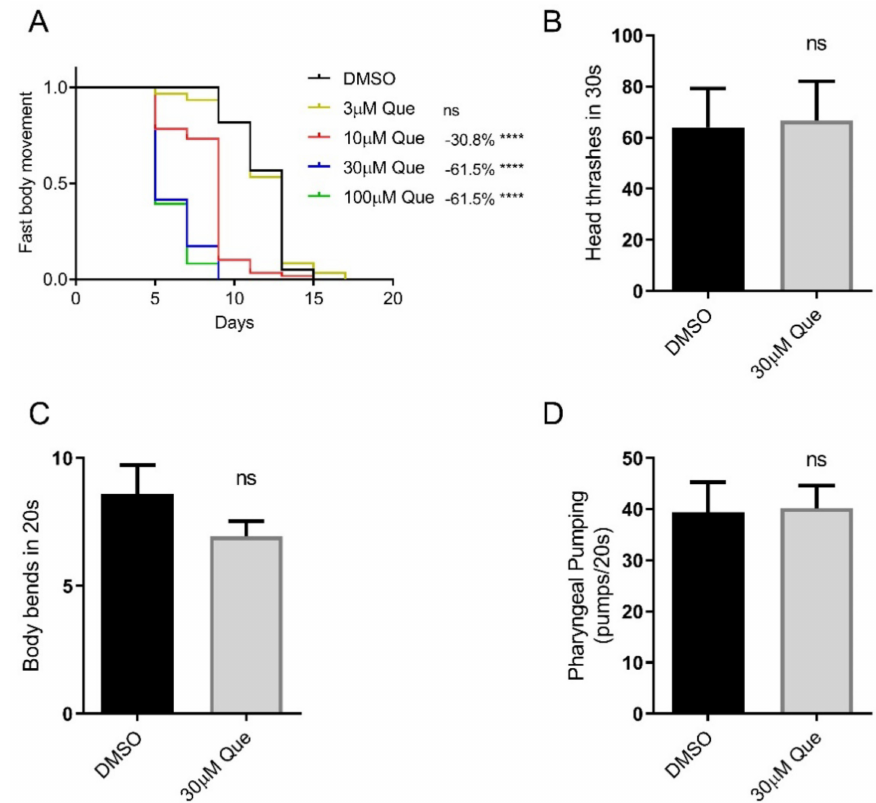
Figure 1. Quetiapine reduces healthspan but does not affect locomotion and pharyngeal pumping of C. elegans . ( A ) Fast body movement spans of wild-type (N2) worms cultured at 20 ◦ C on NGM plates containing indicated concentrations of quetiapine (Que) or DMSO ( n = 60 worms per group) (comparison between DMSO and Que treatment: ns = not significant; ****, p < 0.0001, log-rank test). ( B , C ) Head thrash frequencies ( n = 15 worms per group) ( B ) and body bend frequencies ( n = 15 worms per group) ( C ) of N2 animals treated with 30 µ M of quetiapine or DMSO for 5 days (comparison between DMSO and Que treatment: ns = not significant, t -test). ( D ) Pharyngeal pumping rates of N2 animals treated with 30 µ M of quetiapine or DMSO for 7 days ( n = 15 worms per group) (comparison between DMSO and Que treatment: ns = not significant, t -test). Experiments were performed in at least two independent biological